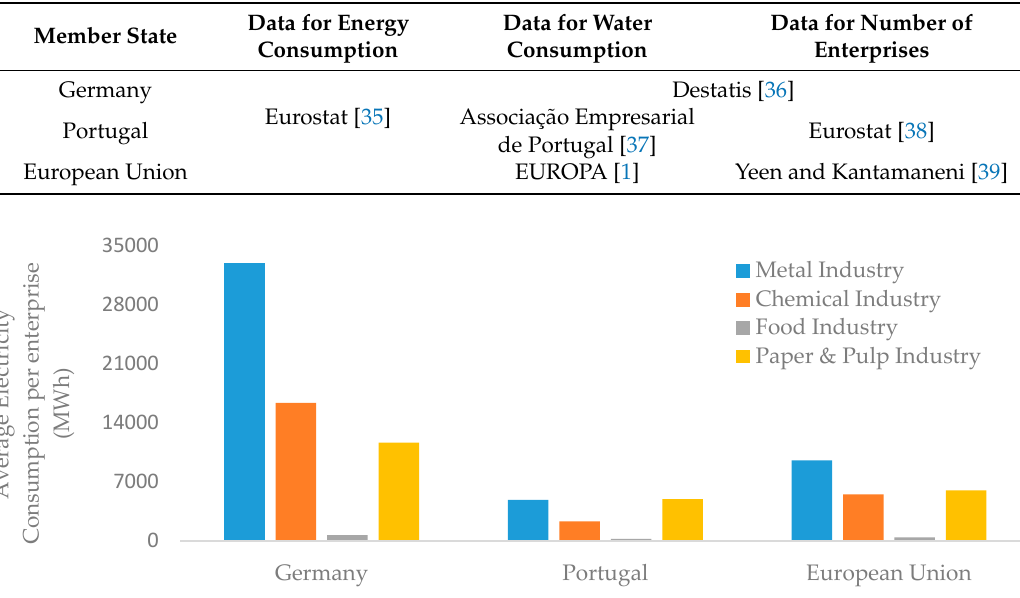
Figure 2. Average electricity consumption for each industrial sector and region (adapted from [34,36 – 38]).